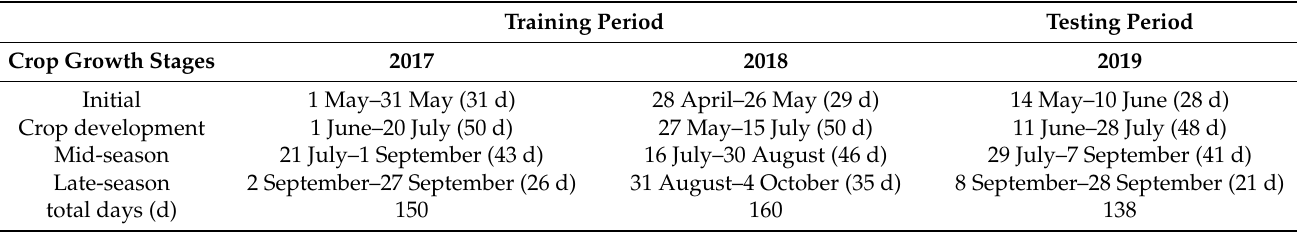
Table 2. The stages of spring maize growing seasons between 2017 and